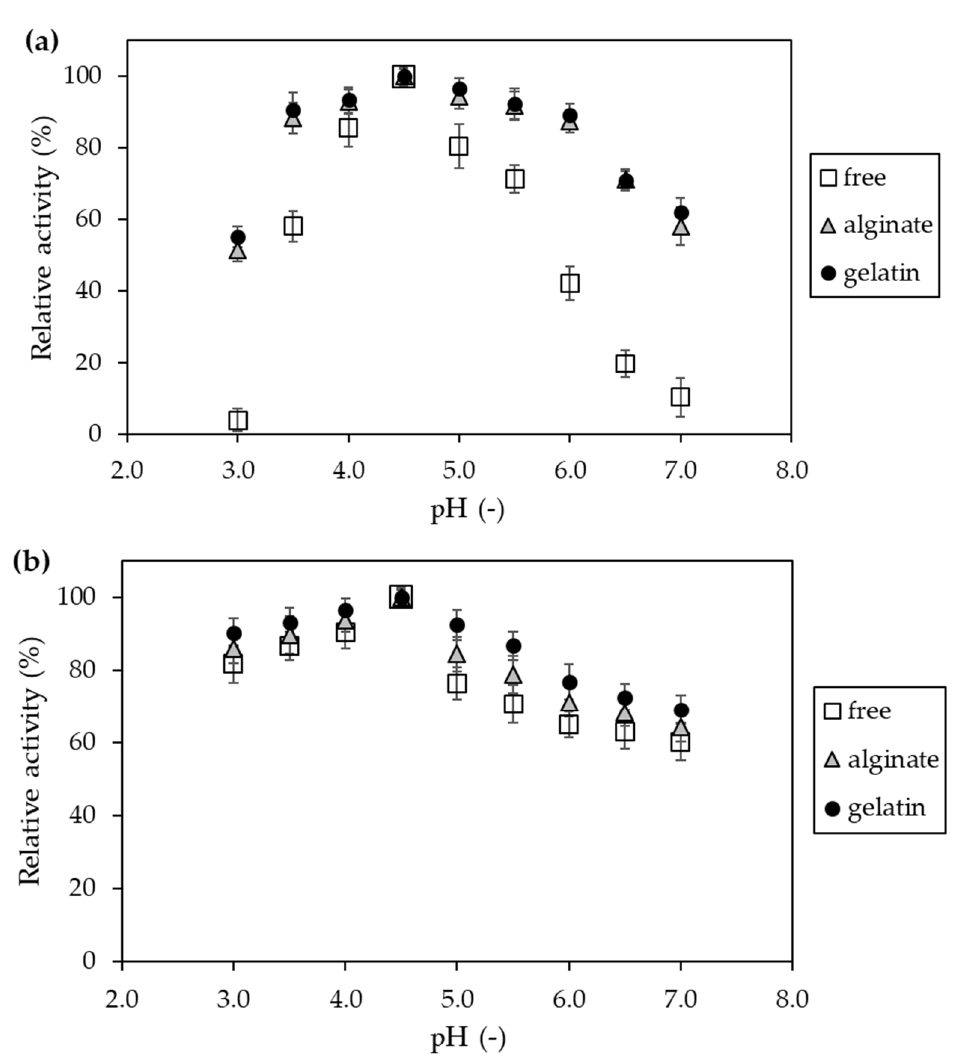
Figure 8. Effect of pH on relative activity ( a ) and stability ( b ) of free invertase (white square) and immobilized in alginate (grey triangle) and gelatin-based hydrogels (black circle). The highest activity value obtained during the experiments was assumed to be 100%.